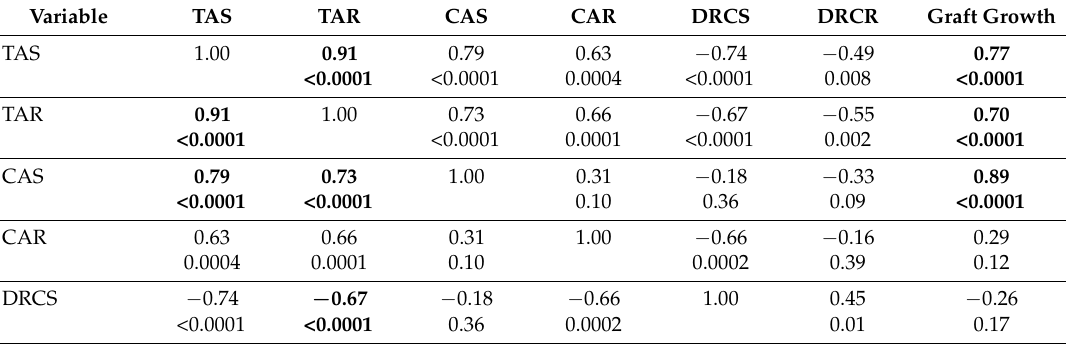
Table 12. Correlation matrix of the variables that could be used for growth prediction, taking into account only the grafts that were alive at the end of the six-month evaluation